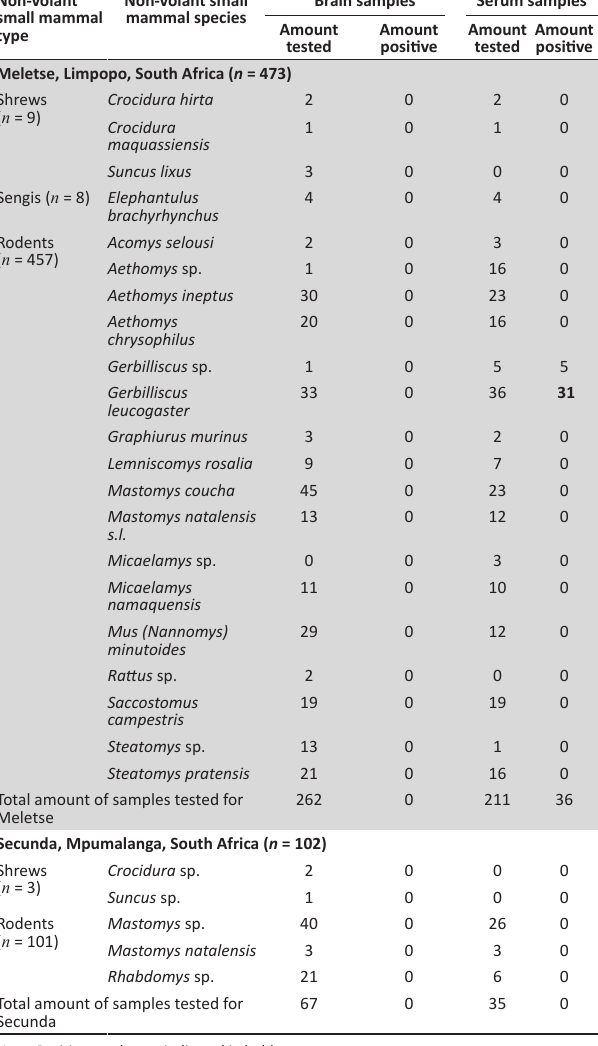
TABLE 1-A1: Non-volant small mammal species included in the surveillance of Mokola virus in South Africa. Non-volant small mammal type